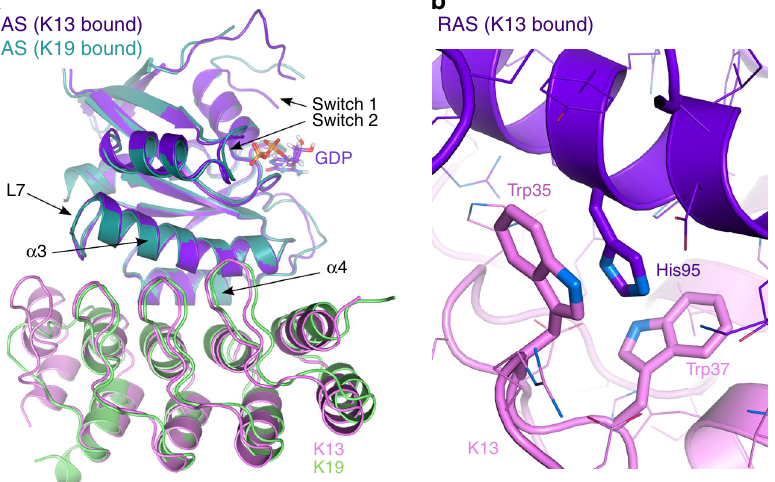
Fig. 1 DARPins K13 and K19 bind KRAS to a novel allosteric site. a X-ray crystal structures of KRAS G12V -GDP-bound to DARPin K13 (PDB 6H46) and KRAS G12V -GDP-bound to DARPin K19 (PDB 6H47) with the indication of RAS switch regions, helix 3 ( α 3), helix 4 ( α 4) and loop 7 (L7) regions. b Expanded view of the interaction between the DARPin K13 and KRAS around histidine residue 95 of